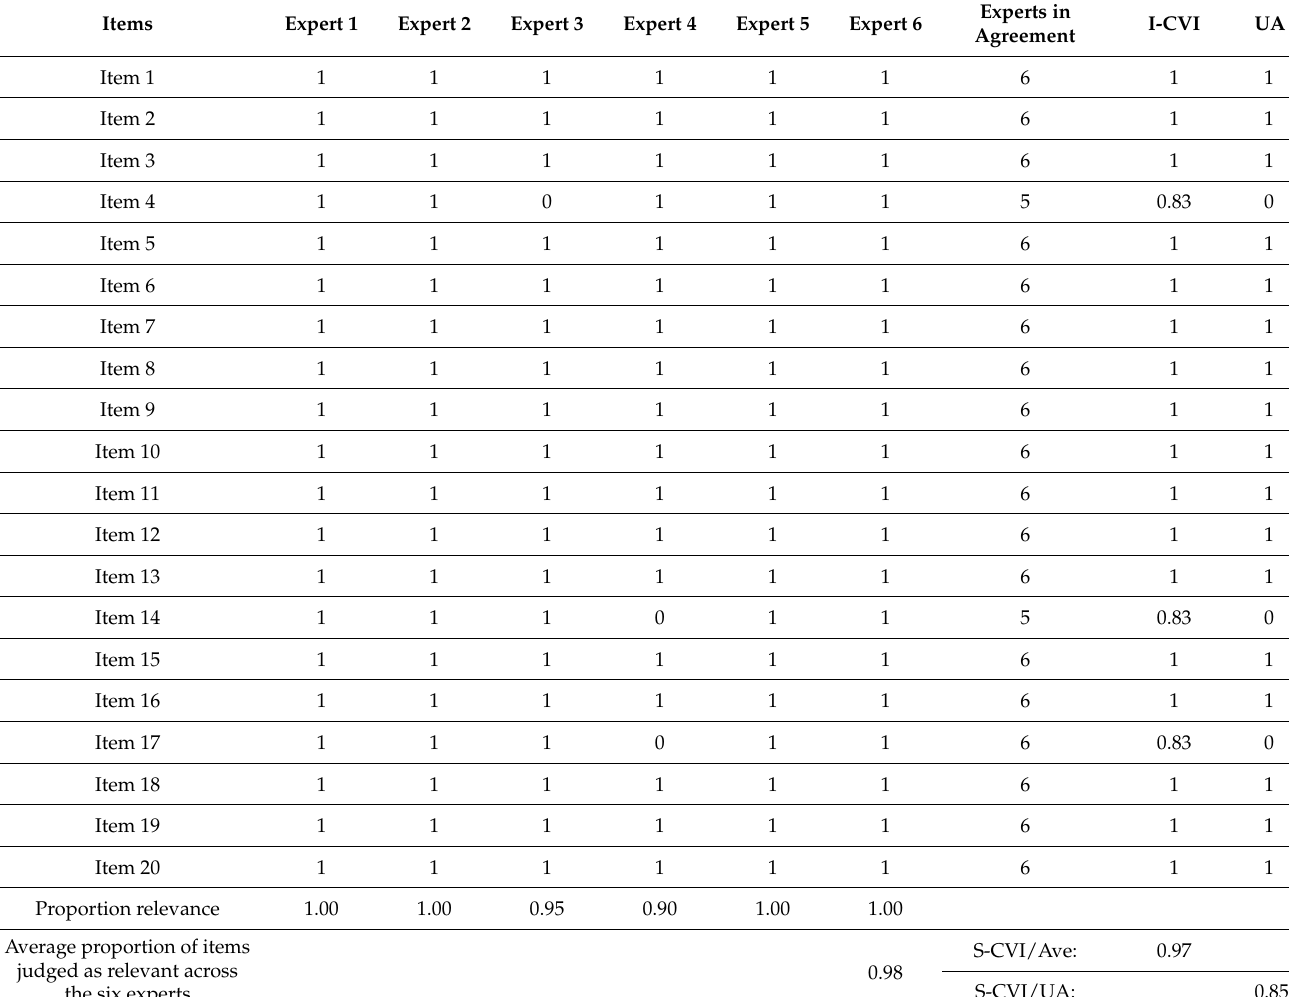
Table 2. Content validity index (CVI) of the SSS-M by six